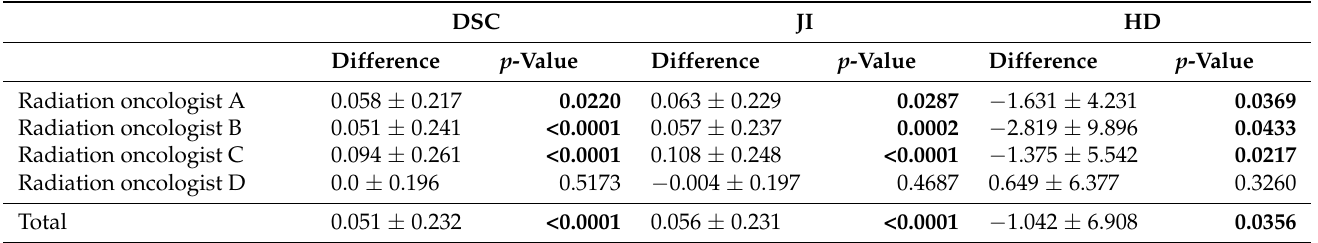
Table 2. Comparison results of the Dice similarity coefficient, Jaccard index, and Hausdorff distance for each radiation oncologist between the initial and repeated studies. DSC JI